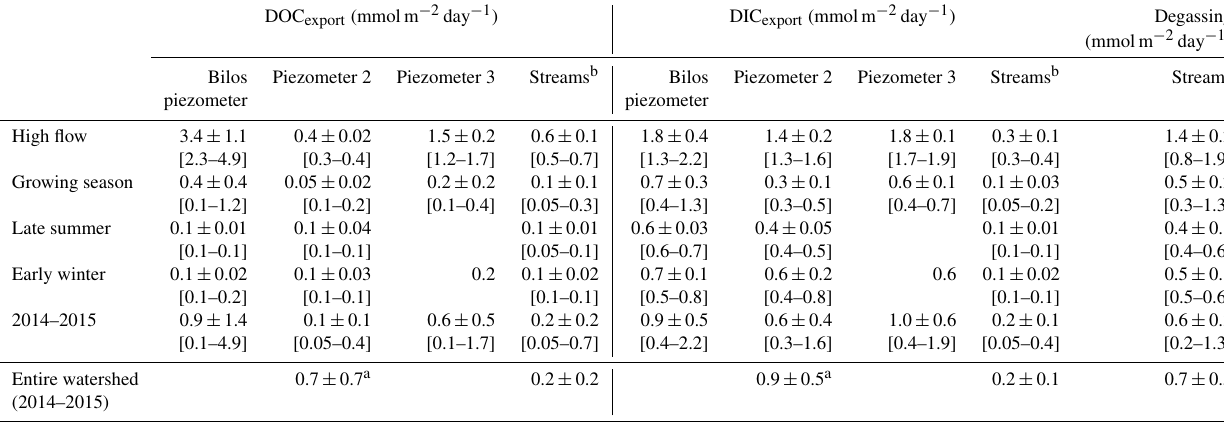
Table 5. Export of DIC and DOC from the sampled groundwater to first-order streams, as well as degassing in first-order streams, for the sampling period and for high-flow (January–March 2014 and February–March 2015), growing season (April–August 2014 and April– August 2015), late summer (September–October 2014 and September–October 2015) and early winter (November 2014–January 2015 and November–December 2015) periods. Numbers represent the mean ± SD whereas numbers in square brackets represent the range. Here, degassing was calculated with the DIC data from the three sampled